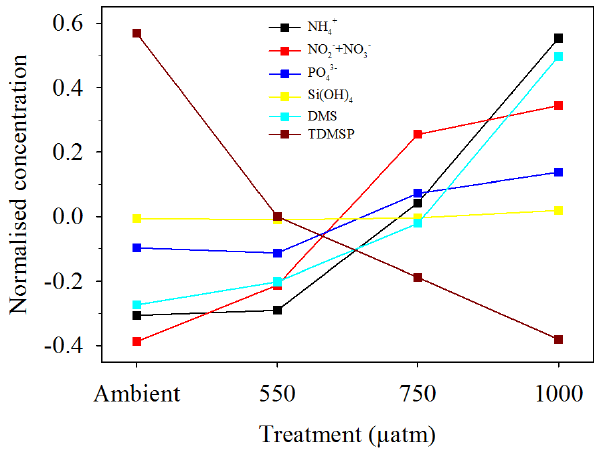
Figure 10. Normalised plot of changes in inorganic nutrient and DMS/TDMSP concentration with P CO 2 treatment for collated bioassay data.